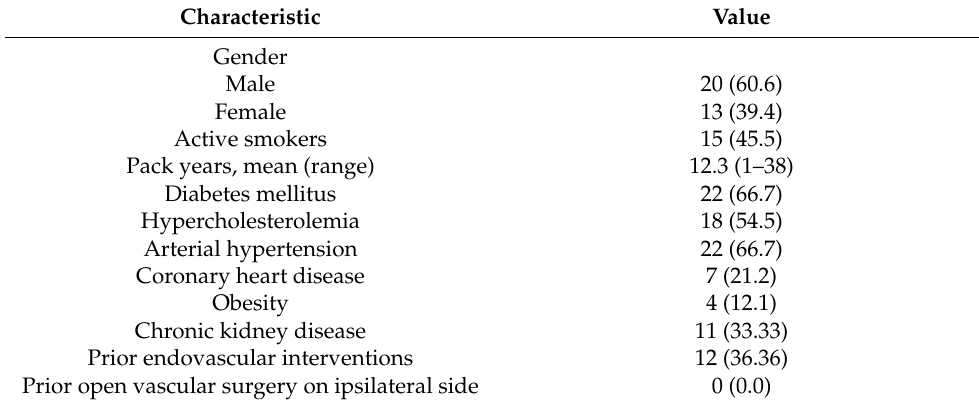
Table 1. Preexisting